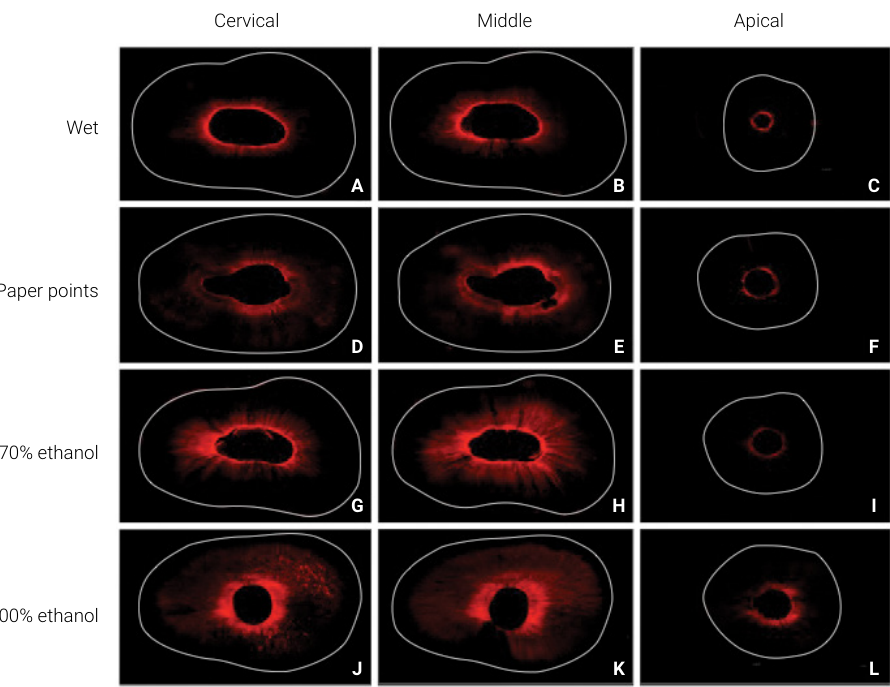
Figure 3. CLSM images according to drying methods and root canal thirds. A – C: wet group images showed lower penetration of sealer into dentinal tubules at all thirds; D – F: Paper points group images with more penetration of sealer into dentinal tubules, than wet groups; G – I: 70% ethanol group images showed better sealer penetration, when compared to wet and paper points group and J – L: 100% ethanol group images presented a greater amount of sealer penetrated into dentinal tubules, especially at middle